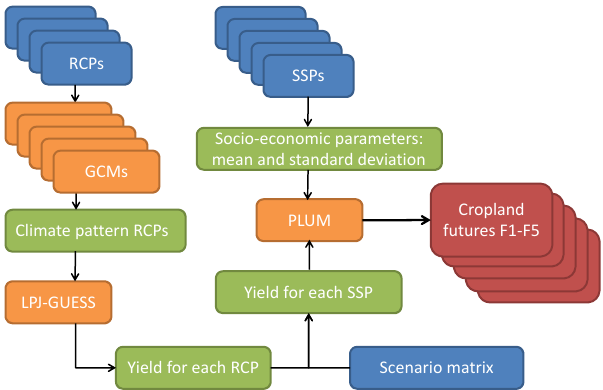
Figure 1. The SSP–RCP modelling framework. The RCPs and SSPs, as well as the scenario matrix (author judgement about the distribution of RCPs conditional on SSPs), are input to the model (indicated in blue). Models (indicated in orange; GCMs: general circulation models) use input or results of other models (intermedi- ate results, indicated in green). The final outputs of the modelling framework are the cropland futures F1–F5 (indicated in